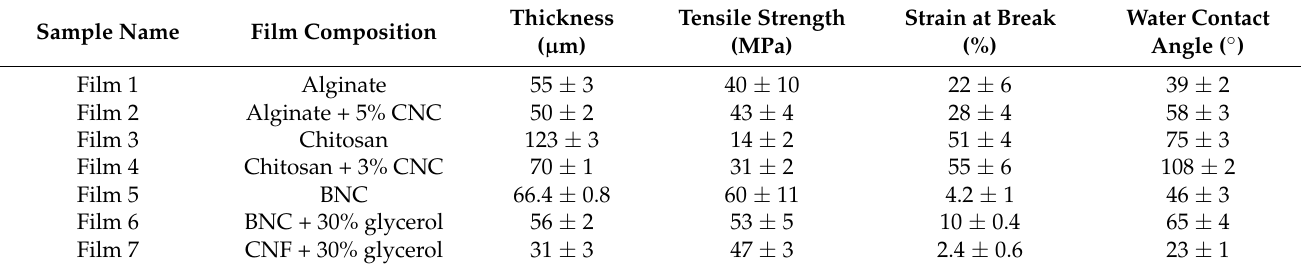
Table 1. Selected polysaccharide films are based on the specified properties and include the most promising candidate from each biopolymer. These films are also subjected to a full characterization of morphological and barrier properties (values are given as mean ±